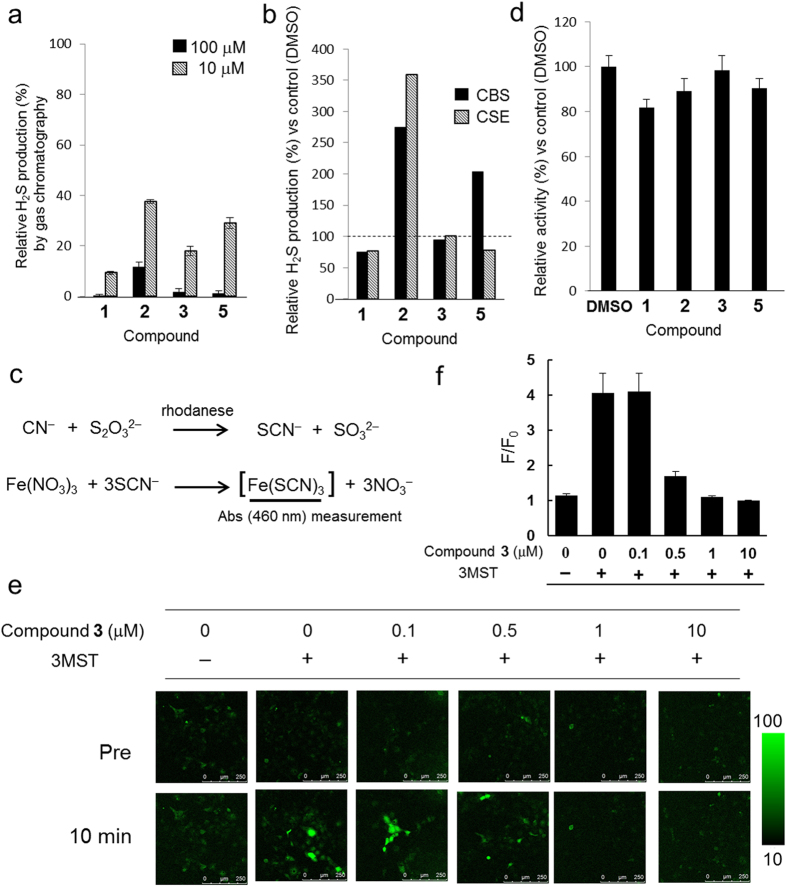
Selectivity assessment of hit compounds for 3MST over other H2S/polysulfides-producing enzymes and rhodanese.(a) 3MST-Inhibitory activity of hit compounds at 10 and 100 μM in cell lysate of 3MST-expressing HEK293 cells. 100 μM 3MP and 100 μM DTT were added to the solution containing 0.1% DMSO as a cosolvent, and the mixture was incubated at 37 °C for 15 min. H2S production was measured by gas chromatography. All data are presented as the mean ± S.D. (100 μM: n = 3 or 4; 10 μM: n = 3). (b) Selectivity assessment of hit compounds at 100 μM towards CBS and CSE. Only DMSO was added to the control sample instead of DMSO solution containing hit compounds. H2S production was monitored by gas chromatography. All data are presented as the mean (n = 3). (c) Detection method for rhodanese activity (Sörbo method). (d) Selectivity assessment of hit compounds towards rhodanese. The results are mean ± S.D. (n = 4, three times). These values were determined based upon the absorbance of [Fe(SCN)3] at 460 nm (Sӧrbo method). Bovine rhodanese 1.3–1.7 units/mL, substrate: 52 mM Na2S2O3, 50 mM KCN, 0.004% (w/v) BSA, 100 μM compound and DMSO 1% (v/v) in 88 mM potassium phosphate buffer (pH 8.6) at room temperature for 5 min incubation. (e) Fluorescence confocal microscopic images of live COS7 cells transfected with 3MST or an empty vector9 as a control. Cells were incubated with 50 μM SSP4, a fluorescent probe for sulfane sulfur, and 10 μM, 1 μM, 0.5 μM, 0.1 or 0 μM compound 3 in DMEM containing 0.6% DMSO for 30 min, then washed with HBSS and placed in fresh DMEM with 0‒10 μM compound 3 (Pre). 500 μM 3MP was added to the cells and the cells were incubated for 10 min (10 min). (f) Graphic representation of (e). F/F0 was calculated by dividing the fluorescence intensity of cells after addition of 500 μM 3MP (10 min) by that of cells before addition of 500 μM 3MP (Pre), then the mean F/F0 was determined from 5 cells. All data represent the mean ± standard error of the mean (SEM) of three experiments.